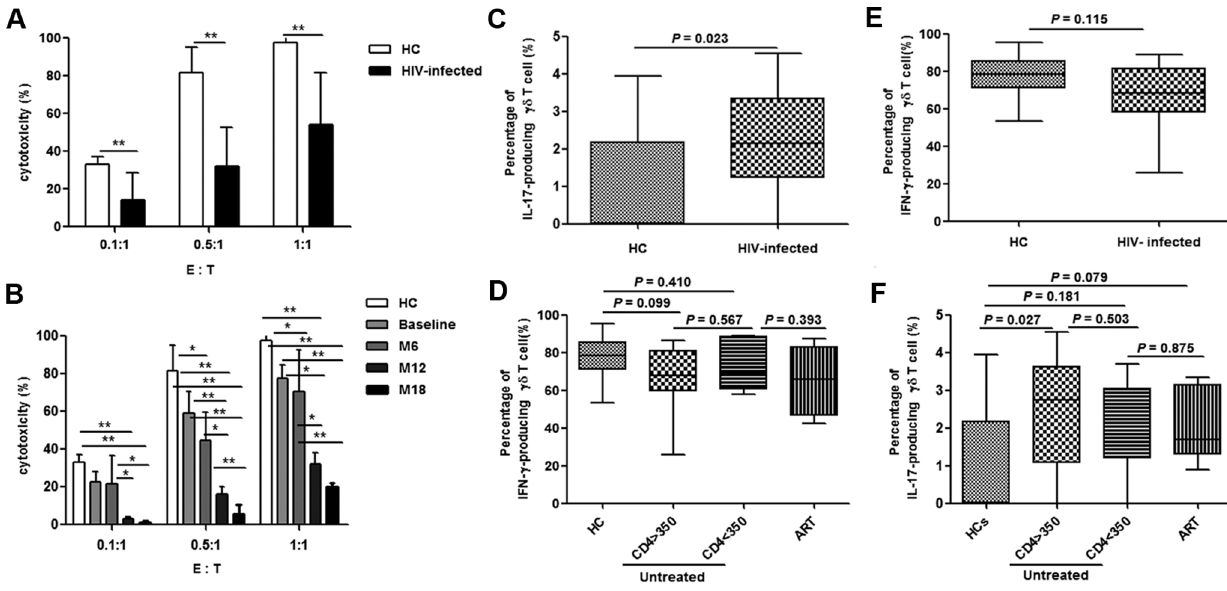
Figure 3. Altered functions of cd T cells in acute HIV infection. Cytotoxicity (%) was assessed at different effector (E, cd T cells) to target (T, Daudi cells) ratios (0.1:1, 0.5 m 1 and 1:1) at baseline ( A ). Subsequently, longitudinal follow-up analysis of cytotoxicity was conducted at different time- points [baseline, month 6 (M6), month 12 (M12) and month 18 (M18)] ( B ). Frequencies of IFN- c - and IL-17-producing cd T cells were analyzed in healthy controls (HC) and acutely HIV-infected subjects at baseline ( C, E ). The patients were then subdivided based on the administration of antiretroviral therapy (ART) and CD4 levels ( , or . than 350/ m L). The frequencies were re-analyzed and compared with HC ( D, F ). *: P , 0.05, **: P ,